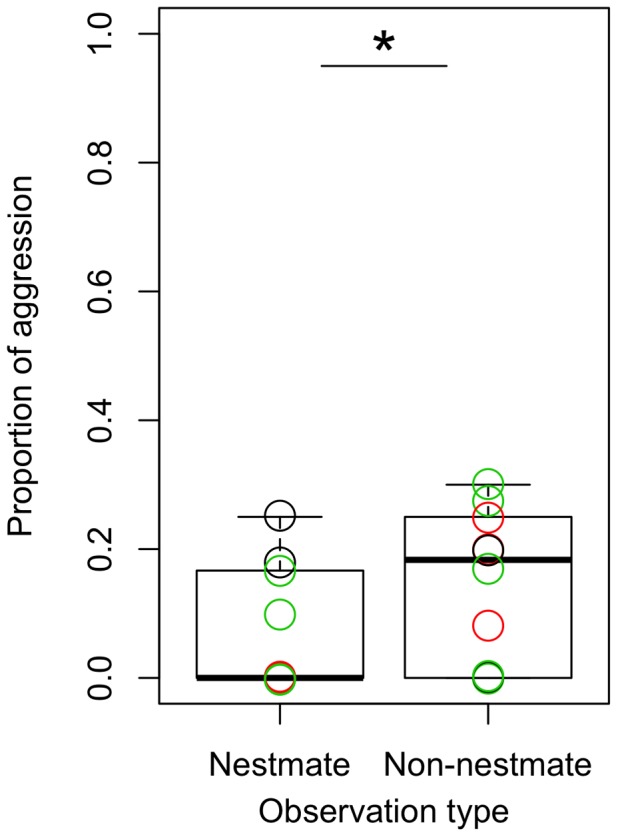
Proportion of aggressive behavior by Cr. levior in behavioral assays with nestmate and non-nestmate Ca. femoratus ants.Black circles are within Cr. levior Type B, green circles are within Cr. levior Type B, and red circles are for between Cr. levior Type A and Cr. levior Type B colony pairs. The asterisk indicates there was significantly more aggression to non-nestmates (p<0.10).